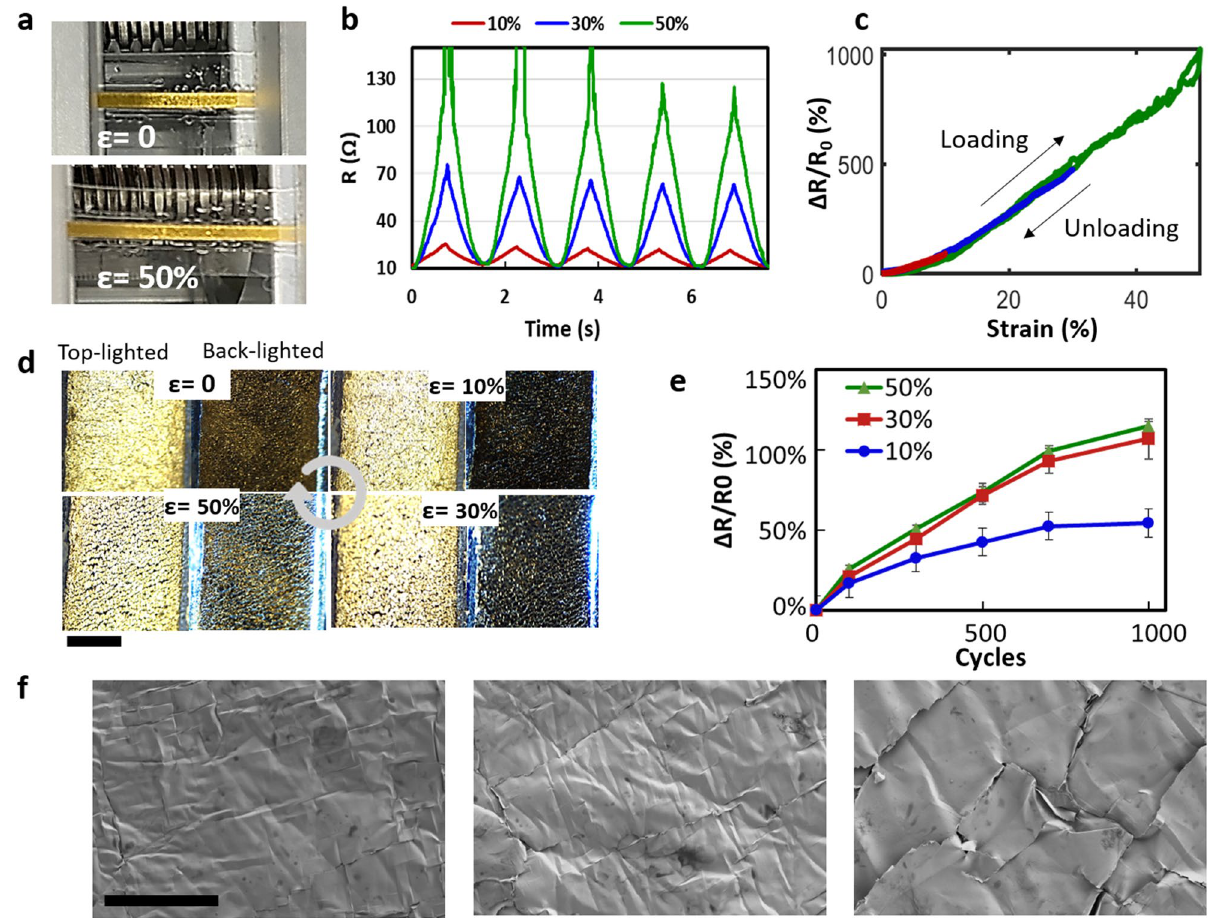
Figure 4. Mechanical characterisation of the strain sensor. ( a ) Strain sensor elongated up to a strain of 50% using a custom-built strain testing setup. ( b ) Resistance changes during the first five stretching/relaxation cycles of the strain sensor with different strains, showing a stabilising behaviour. ( c ) Δ R / R curves versus the strain with maximum elongations of 10, 30, and 50%, showing the linear response to the strain. ( d ) Top-lighted and back- lighted microscopic observation of the gold surfaces in the course of stretching from 0 to 50% (scale bar: 1 mm). ( e ) Baseline resistances at relaxed states after completing an increasing number of cycles for different maximum strains. ( f ) SEM images of gold surfaces before (left) and after 1000 repetitions of application of strains of 10% (centre) and 50% (right) (scale bar: 50 process). GOx oxidises the glucose in sweat to produce hydrogen peroxide (H 2 O 2 ), which is reduced by a redox mediator layer, typically Prussian blue (PB), so that the concentration can be quantified by measuring the cur- rent by constant-potential chronoamperometry (CA). Figure 5b shows CA response curves at a potential of − 0.4 V for increasing glucose concentration from 0.01 to 5 mM. Well-defined current signals corresponding to increasing glucose concentrations were observed with stable responses obtainable within 30 s. The calibration plot in Fig. 5c indicates a linear relationship between the output current and glucose concentration in the range of 0.01 to 0.1 mM, the typical glucose levels in human sweat 42 . The inset shows the calibration curve in the whole range, with an almost linear trend up to 0.1 mM, which levels off above a glucose concentration of 1 mM. The selectivity of the sensor was investigated in the presence of physiological molecules in sweat, including ascor- bic acid (AA), uric acid (UA), and acetaminophen (AP). Compared to the response of glucose droplets (1 and 0.1 mM), the CA curve in Fig. 5d presents negligible interference signals when 1 mM of UA, AP, and AA were sequentially dropped. Considering that the concentrations of these molecules in human sweat (AA, AP: 1 μM; UA: 5 μM) are considerably lower than 1 mM used in the test, this observation implies an excellent selectivity of the sensor towards glucose molecules. The sensor could stably produce CA responses to 0.1 mM glucose concentration under uniaxial stretching of 10% and 30% when compared to the response at the rest state (ε = 0%) as shown in Fig. 5e. Elongation of the sensor up to 50% resulted in delamination of the relatively rigid functionalizing layers (drop-casted enzyme and silk-screened PB and Ag/AgCl layers) from the underlying stretchable gold layer, leading to unstable CA response. The inset in Fig. 5e shows sensing performance after repetitive stretching cycles, indicated by the relative sensitivity (S/S 0 ), where S and S 0 are the CA responses to 0.1 mM glucose before and after the repeated strain, respectively. The sensor demonstrated relatively stable responses without significant degradation of initial